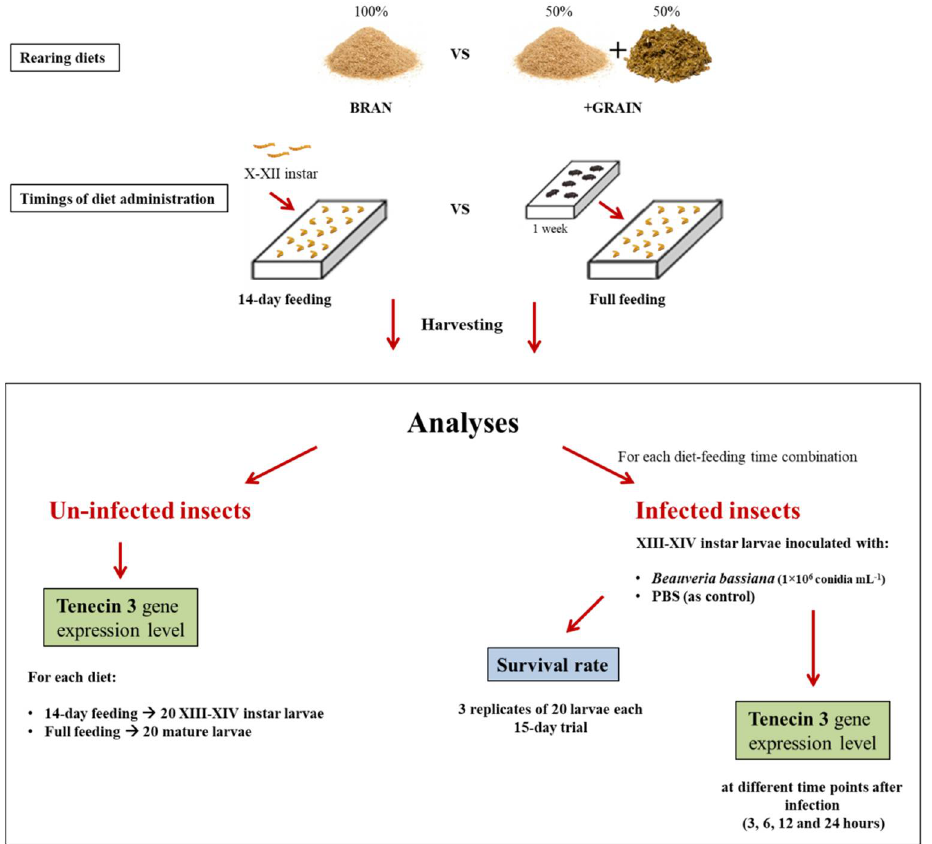
Figure 1. Experimental design and description of the analyses preformed on uninfected and infected insects. Tenebrio molitor larvae or adults were reared on BRAN or +GRAIN diet for different timings of diet administration. Groups of X-XII instar larvae were collected and reared on the tested diets for 14 days prior to being used in the trials (14-day feeding) or adults were allowed to oviposit directly on the tested substrates and the new generation was used in the trials (full feeding). Depending on the trial, different instars of T. molitor larvae were analyzed. In the first trial, Tenecin 3 expression level was evaluated in XIII-XIV and mature uninfected larvae were fed the different diets for 14-day feeding or a full feeding period. Subsequently, for each diet and feeding time combination, groups of XIII-XIV larvae were inoculated by injection with B. bassiana or PBS, as control. Two trials were performed. In the first one, the survival rate of infected insects was assessed in a 15-day trial. In the second one, Tenecin 3 transcriptional level was evaluated in groups of larvae collected 3, 6, 12 and 24 h after injection.